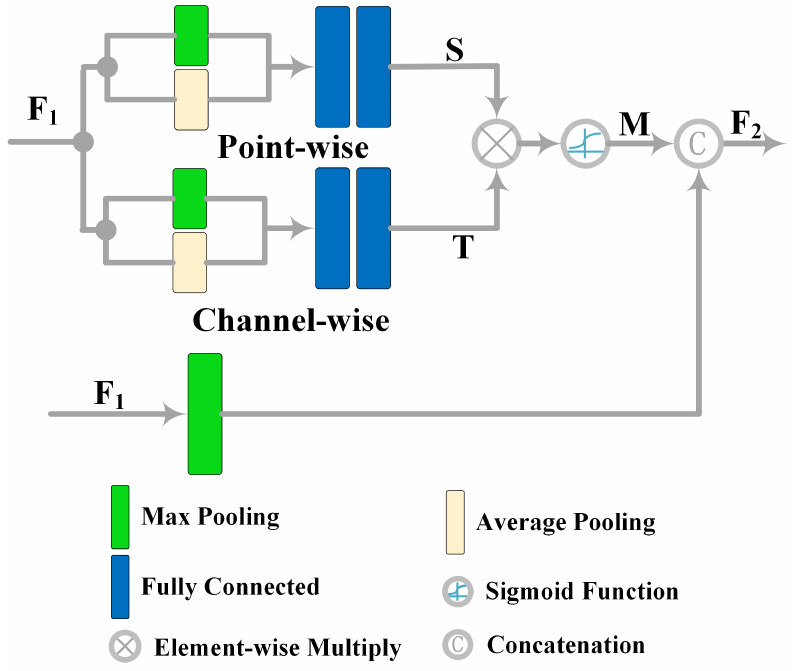
Figure 4. HA module